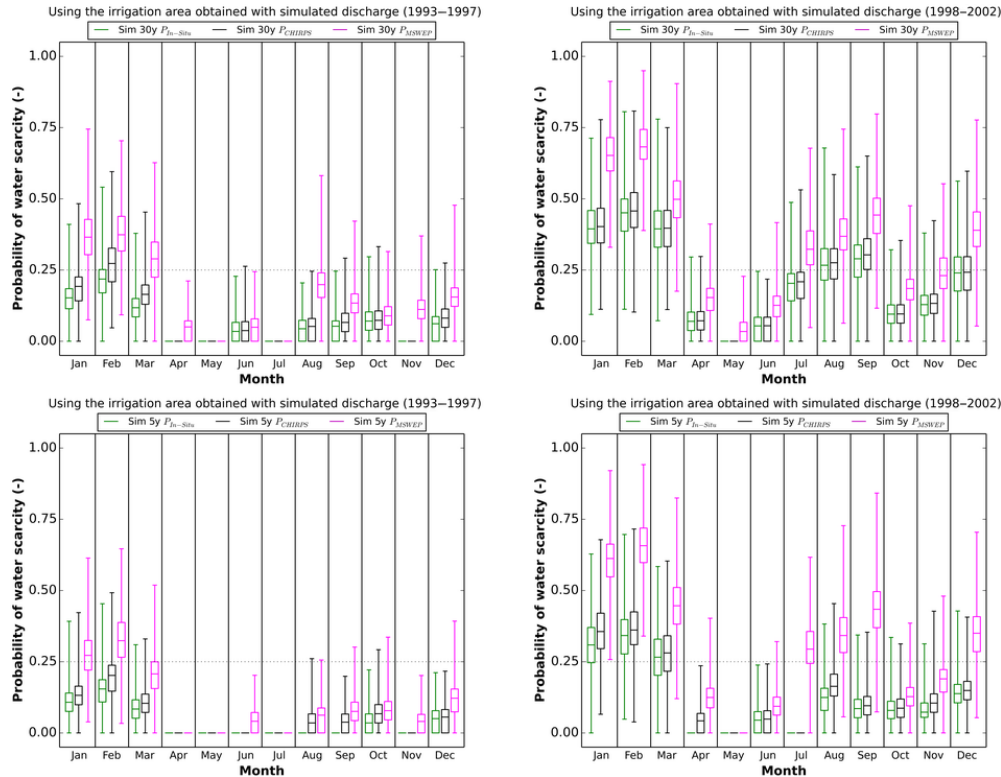
Figure 8. Probability of water scarcity using the irrigation area obtained with simulated river discharge information (Sim 30yr P insitu , Sim 30yr P CHIRPS , Sim 30yr P MSWEP ; Sim 5yr P insitu , Sim 5yr P CHIRPS , Sim 5yr P MSWEP ) and the reference surface water availability. Boxplots show the median, interquartile range and minimum–maximum